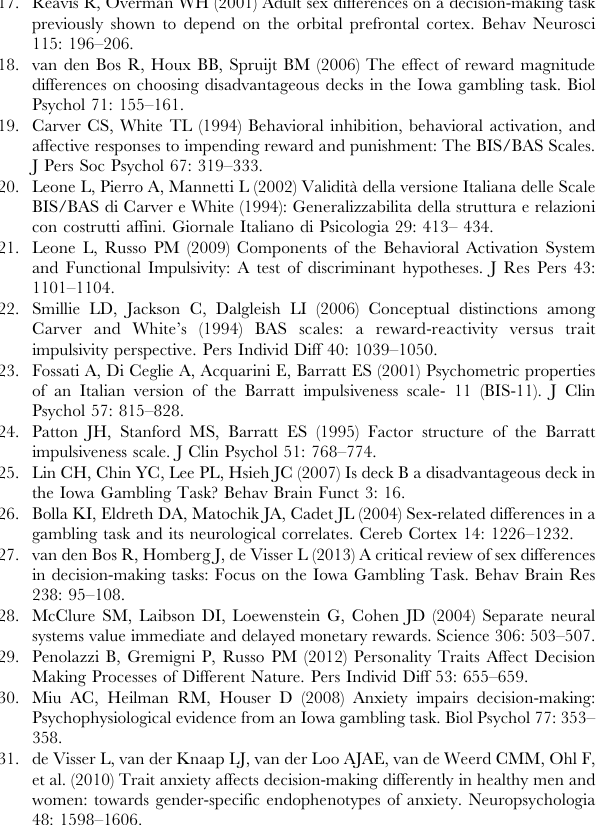
women: towards gender-specific endophenotypes of anxiety. Neuropsychologia 48: